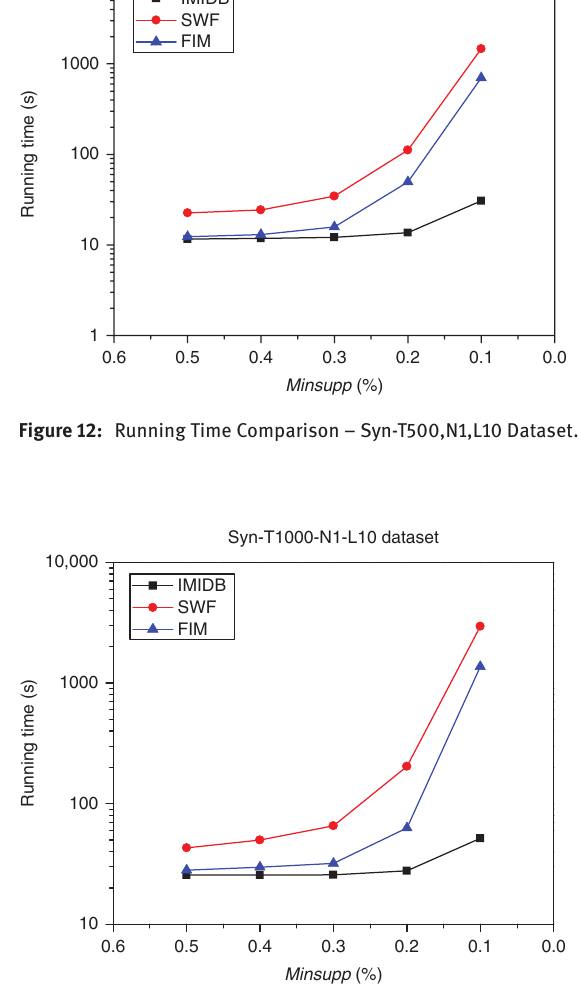
Figure 13: Running Time Comparison – Syn-T1000,N1,L10